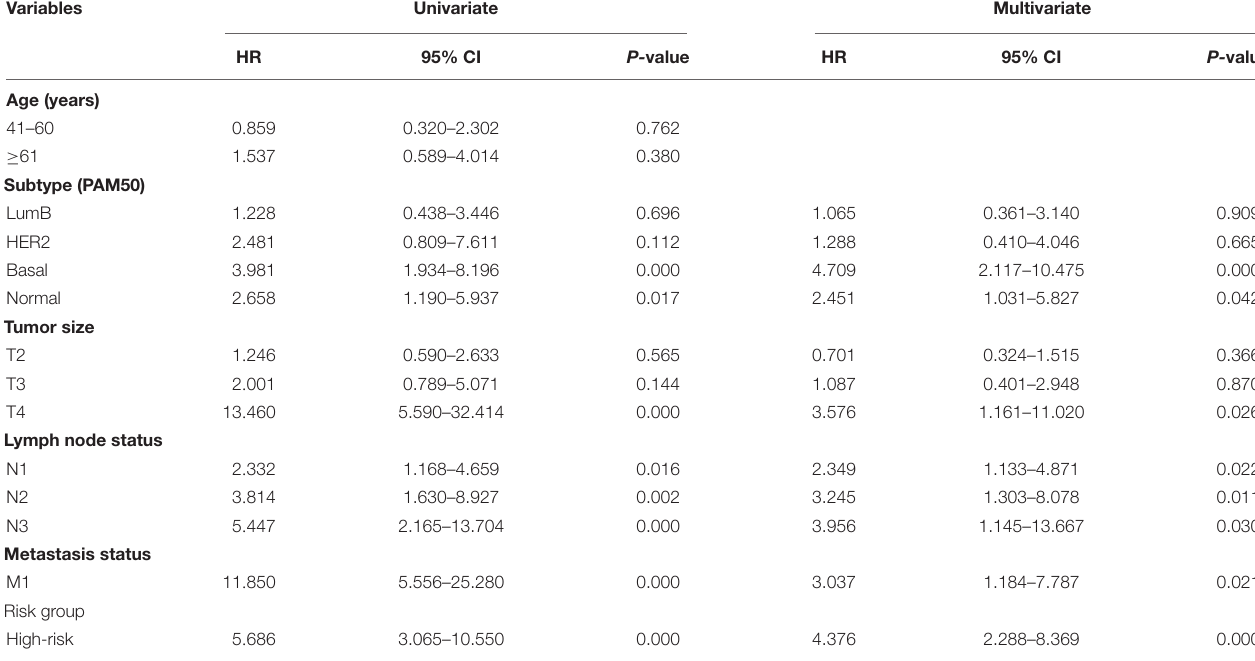
TABLE 5 | Univariate and multivariate Cox proportional hazard models of DSS in breast cancer. Variables Univariate